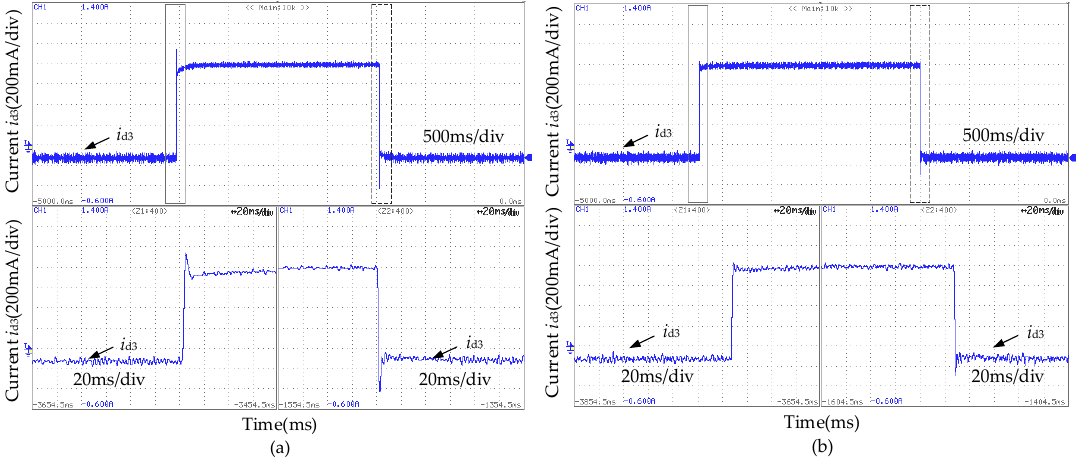
Figure 11 . The experimental results of battery current i d3 : ( a ) traditional frequency control; ( b ) LADRC.